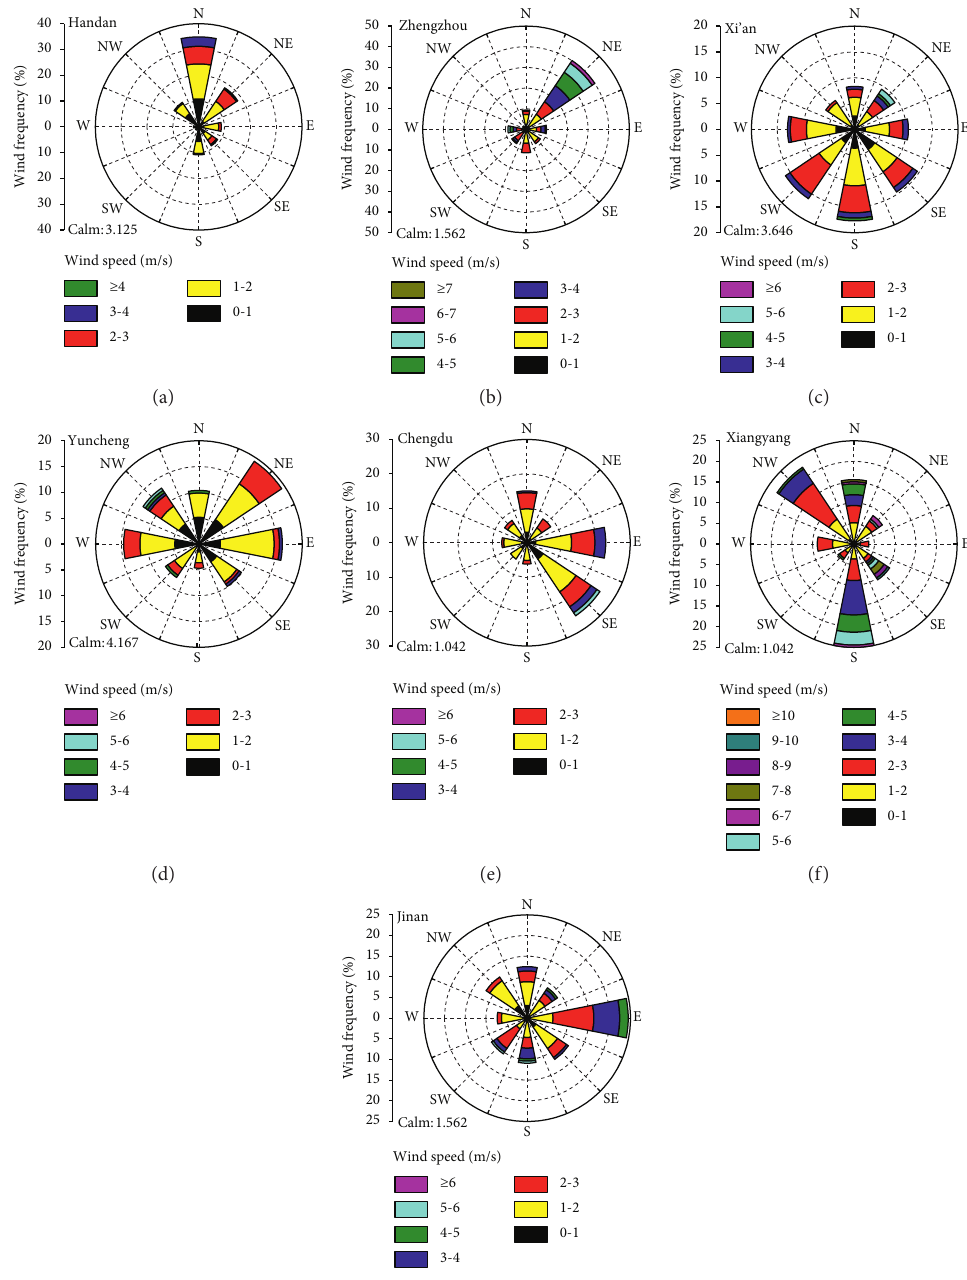
Figure 5: Wind rose plots for seven Chinese cities. Calms represent wind speeds < 1 m · s − 1